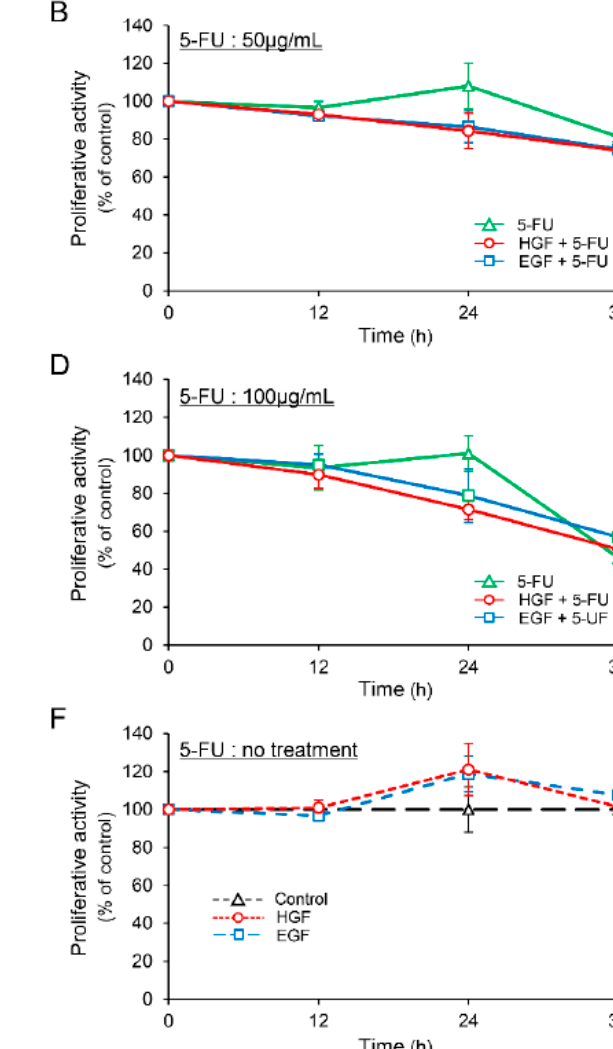
Figure 1. Hepatocyte growth factor (HGF) and epidermal growth factor (EGF) suppress proliferative activity in HepG2 cells treated with 5-fluorouracil (5-FU). HepG2 cells were cultured for 24 h in serum-starved medium. Incubation was continued with addition of either HGF (50 ng/mL) or EGF (50 ng/mL) for further 7 h. Thereafter, 5-FU (25 µ g/mL: ( A ) 50 µ g/mL: ( B ) 75 µ g/mL: ( C ) 100 µ g/mL: ( D ) 125 µ g/mL: ( E )) and vehicle ( F ) were added. The proliferative activity was measured at the indicated times and is expressed as a percentage of the proliferative activity of cells not treated with growth factor and 5-FU at 0 h ( A – E ) or at the corresponding times ( F ). Each bar represents the mean ± SD of 5